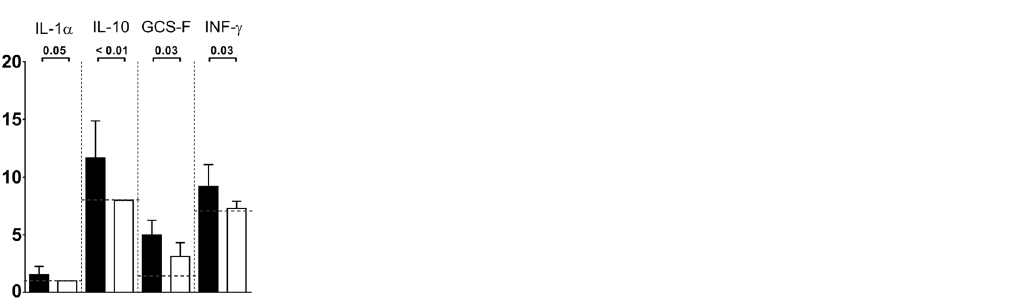
Figure 4. Maternal vaccination reduced systemic inflammation in pups after infection with serotype III GBS. Concentration of inflammatory cytokines (pg/ml) in the blood of infected pups seven days after challenge with GBS M781 serotype III strain. Data from 20–23 mice/group and three independent experiments are reported as geometric mean + 95% confidence intervals. Black bars report data from the negative control group (alum), white bars data from vaccinated group (alum/CPSIII-CRM). The lowest detectable value for each cytokine is represented by the grey dotted line. The Mann–Whitney U test was used to assess significance and the P value for each couple is reported above the